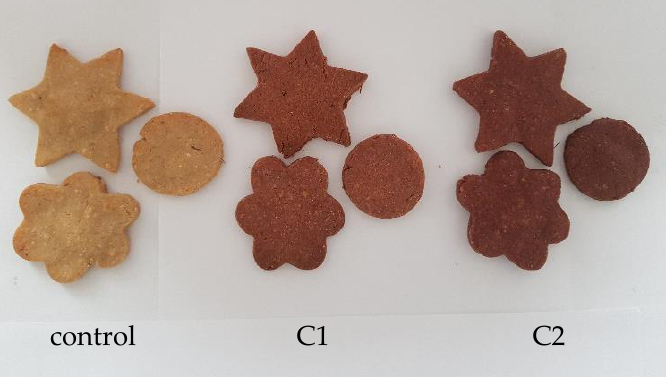
Figure 6. Crackers with different percentages of encapsulated red OS extract: control, 1% (C1), and 3% (C2).